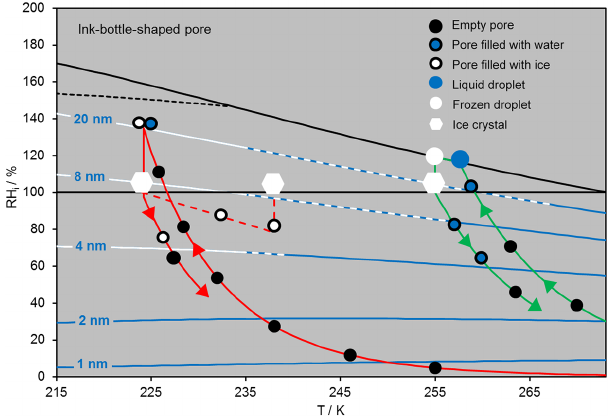
Figure 2. Wet trajectory (green line) and dry trajectory (red line) of a particle with an ink-bottle-shaped pore with a cavity of 20nm and a pore opening of 4nm diameter. Solid lines: adiabatic cooling, followed by adiabatic heating; dashed line: heating to 238K while keeping RH i > 70%. The black horizontal line denotes ice satu- ration; the black sloped line indicates RH i /T conditions for wa- ter saturation (parameterization of Murphy and Koop, 2005). The black dashed line gives homogeneous ice nucleation according to Koop and Zobrist (2009). The white/blue lines delimit the onset of pore filling, which were calculated using the inverse Kelvin equa- tion (Eq. 1). Pores with diameters given on the lines are filled at RH i values above the line and are empty below the line. The white por- tion denotes pore ice, the blue one pore water, and the dashed por- tion pore water or pore ice, depending on the particle history. The limit to high temperature of the dashed portion marks pore melting. Water in pores of 2 and 1nm remains